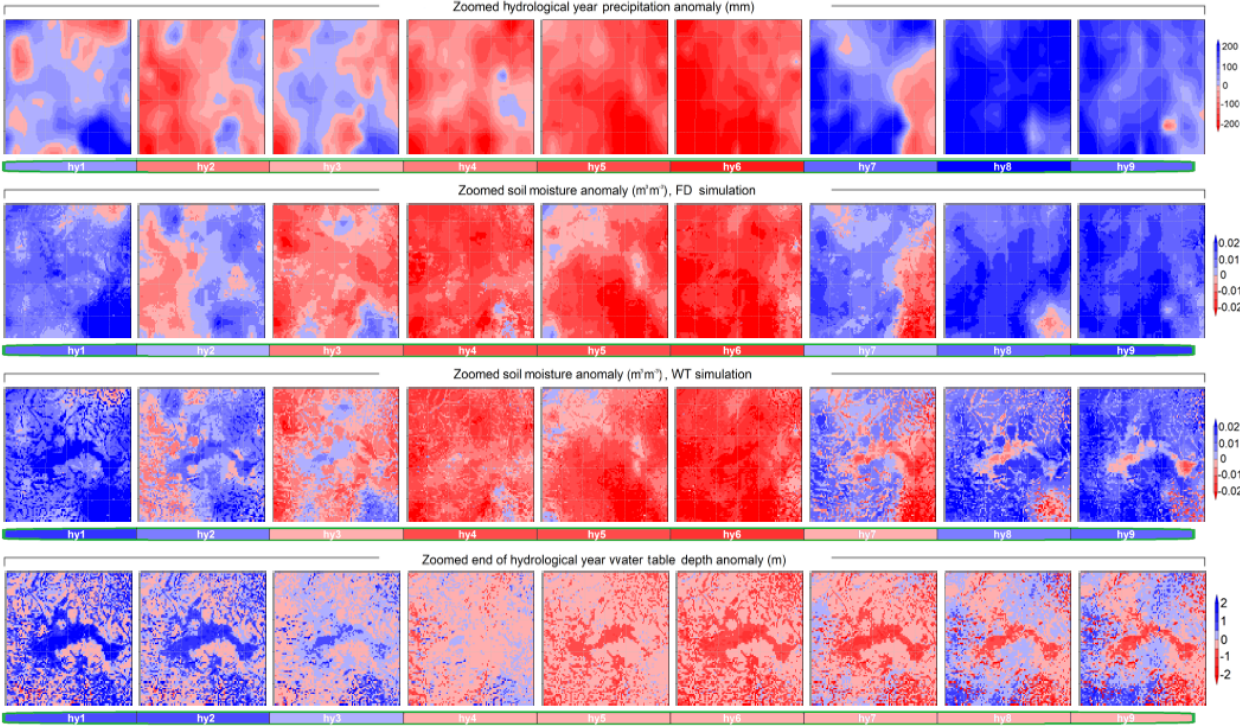
Figure 12. Zoomed hydrological year anomaly plots in the 250 × 225km 2 region highlighted in light green in Fig. 11 (bottom row, first plot), containing La Mancha Húmeda, approximately between 38 and 40.2 ◦ latitude and − 4 . 5 and − 1 . 5 ◦ longitude. Each column corresponds to a complete hydrological year (hy1 to hy9). Rows from top to bottom: total yearly precipitation anomalies (mm), top 2m soil moisture anomalies (m 3 m − 3 ) in the FD run, top 2m year soil moisture anomalies (m 3 m − 3 ) in the WT run, and end of hydrological year (1 September) wtd anomalies (m). Colour bars below each plot represent the averaged anomaly value for the zoomed area.